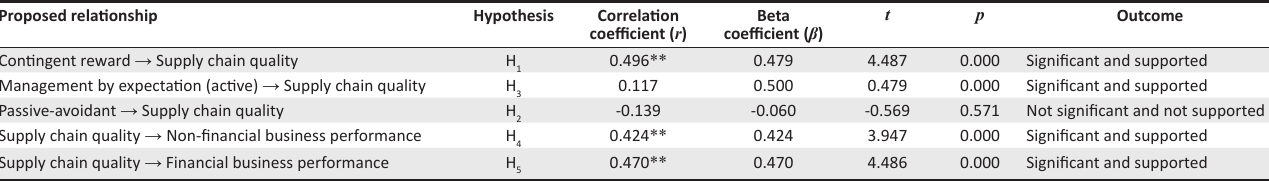
TABLE 10: Outcomes of hypotheses